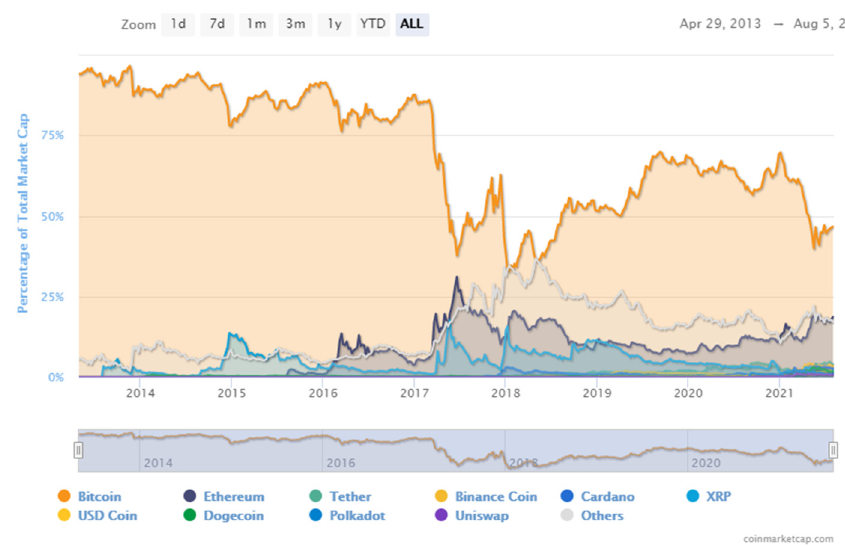
Figure 2. Percentage of Total Market Capitalization (Dominance). Source: https://coinmarketcap.com/ (accessed on 5 August 2021). Note: This figure demonstrates the dominance of Bitcoin in the crypto market.